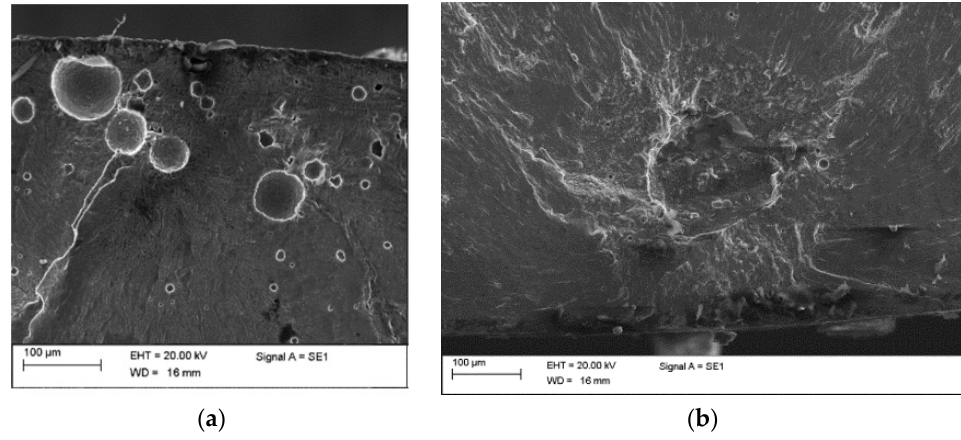
Figure 1. Typical defects in AM parts: ( a ) pores; ( b ) lack of fusion defect.